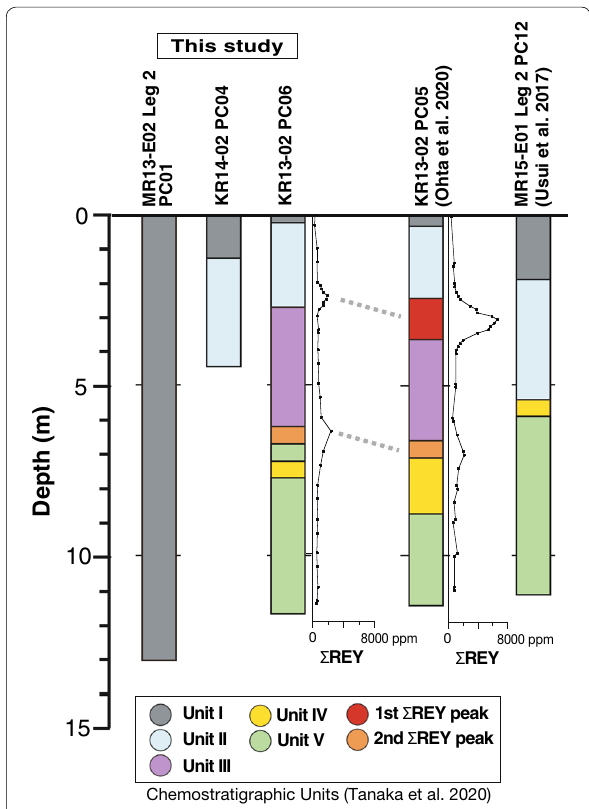
Fig. 2 Chemostratigraphical Units of red clay cores from the western North Pacific Ocean (Tanaka et al. 2020). Three cores studied here (cores MR13-E02 Leg 2 PC01, KR14-02 PC04, and KR13-02 PC06) and nearby cores referred to in the text: cores KR13-02 PC05 (Ohta et al. 2020) and MR15-E01 Leg 2 PC12 (Usui et al. 2017). REY profiles are after Iijima et al. (2016) and Fujinaga et al.